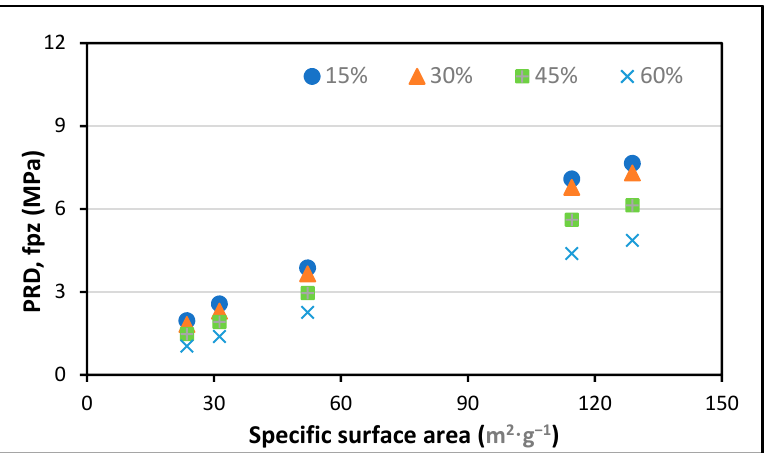
Figure 5. Discrepancy trends of the pozzolanic part with the particle diameter at varying percent- ages.